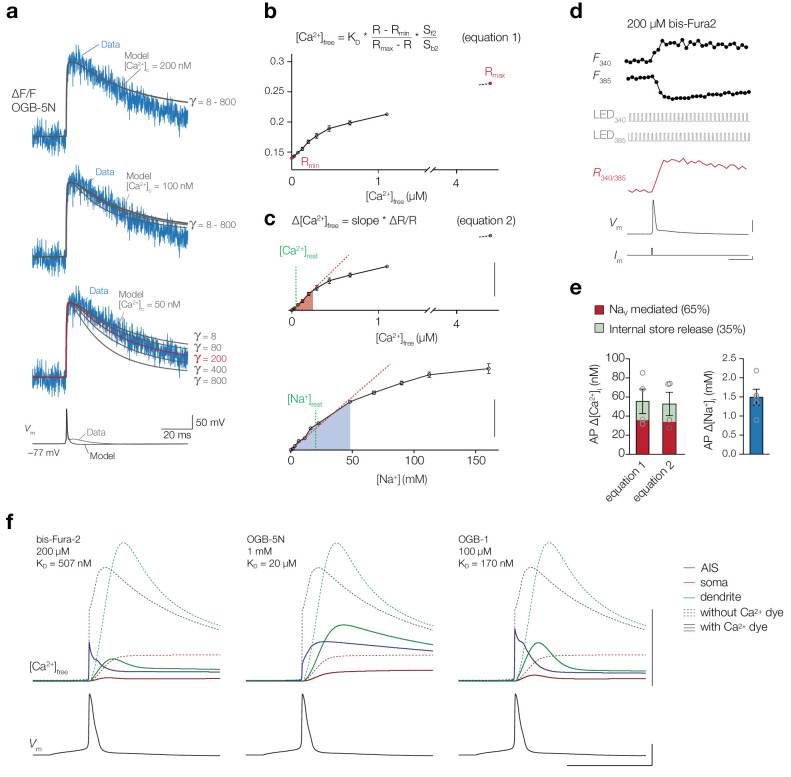
Calibration and modeling of [Ca2+]i.(a) ∆F/F OGB-5N (1 mM, 20 kHz) traces from a representative cell AIS used to optimize Ca2+ extrusion in the model. Imaged ∆F/F (blue) overlaid with the simulated ∆F/F (grey) with varying Ca2+ extrusion thresholds ([Ca2+]c) and flux densities (γ) in the membrane. The optimal fit is indicated in red. (b) Calibration of ratiometric bis-Fura-2 (bF2) signals to solutions with known [Ca2+] to determine KD, Rmin and Rmax used in equation 1, which was subsequently used to convert ratiometric signals into absolute Δ[Ca2+]i. Data shown as mean ± s.e.m (three repetitions). (c) The relationship between changes in fluorescence ratio ΔR/R normalized to the ratio in Ca2+-free or Na+-free solutions, used in equation 2. Data shown as mean ± s.e.m (three repetitions), red dashed line is a linear fit through the mean ΔR/RbF2(0–193 nM, six concentrations) and ΔR/RSBFI(0–48 mM, eight concentrations). Scale bars, 40% and 100%. (d) Example traces of a ratiometric bF2 recording. Top to bottom: fluorescence transients from the AIS upon excitation with 340 and 385 nm (average of 38 trials), TTL pulses triggering the LEDs, fluorescence ratio R340/385, somatic AP and current injection. Scale bars, 40 mV, 4 nA and 10 ms. (e) Absolute increase in [Ca2+]i and [Na+]i in the AIS after 1 AP in the presence of 200 µM bF2 and 1.5 mM SBFI, respectively, separate for the 2 Ca2+ calibration methods from b and c. Bar and error bars represent the mean ± s.e.m., open circles are individual cells. (f) Simulation of distinct Ca2+ dyes on the [Ca2+]i, adjusting the KD and concentration of the simulated exogenous buffer, shown for the AIS (blue), soma (red) and dendrites (green) (locations as specified in Figure 9a) in response to an AP (bottom). Note that OGB-5N, due to its low-affinity, buffers [Ca2+]i more linear in comparison to bis-Fura-2 and OGB-1. Scale bars from top to bottom, 500 nM, 50 mV and 5 ms.